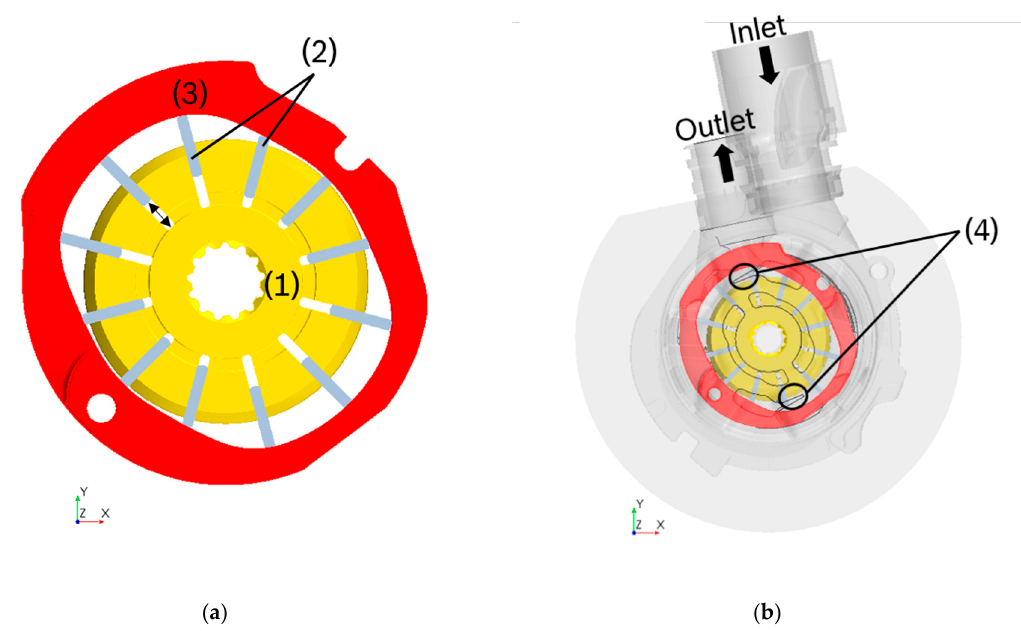
Figure 1. ( a ) Main parts for pump function: (1) rotor, (2) vanes, (3) cam ring; ( b ) main parts in pump housing, (4) grooves. housing, (4)